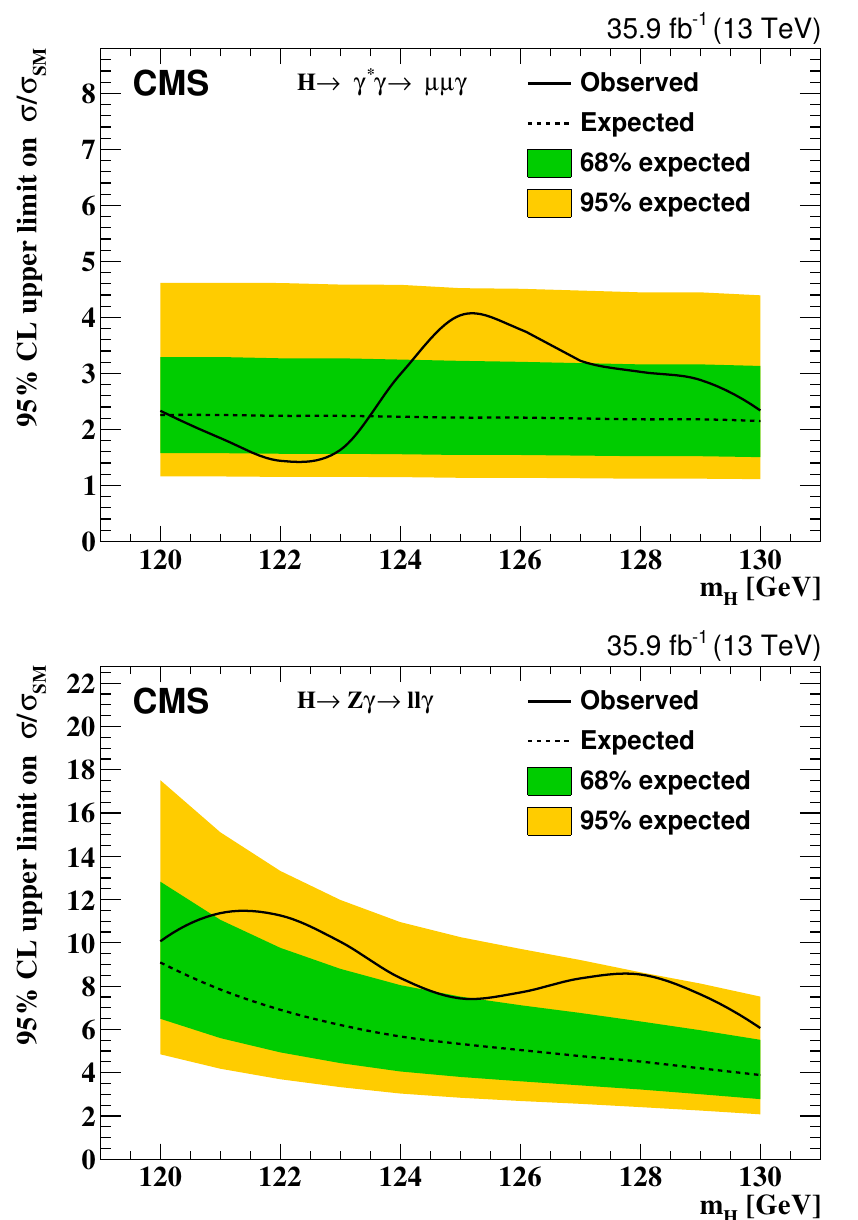
Figure 6 . Exclusion limit, at 95% CL, on the cross section of the H plot) and the H Z (cid:13) ‘‘(cid:13) process (lower plot) relative to the SM prediction, as a function of ! ! the Higgs boson